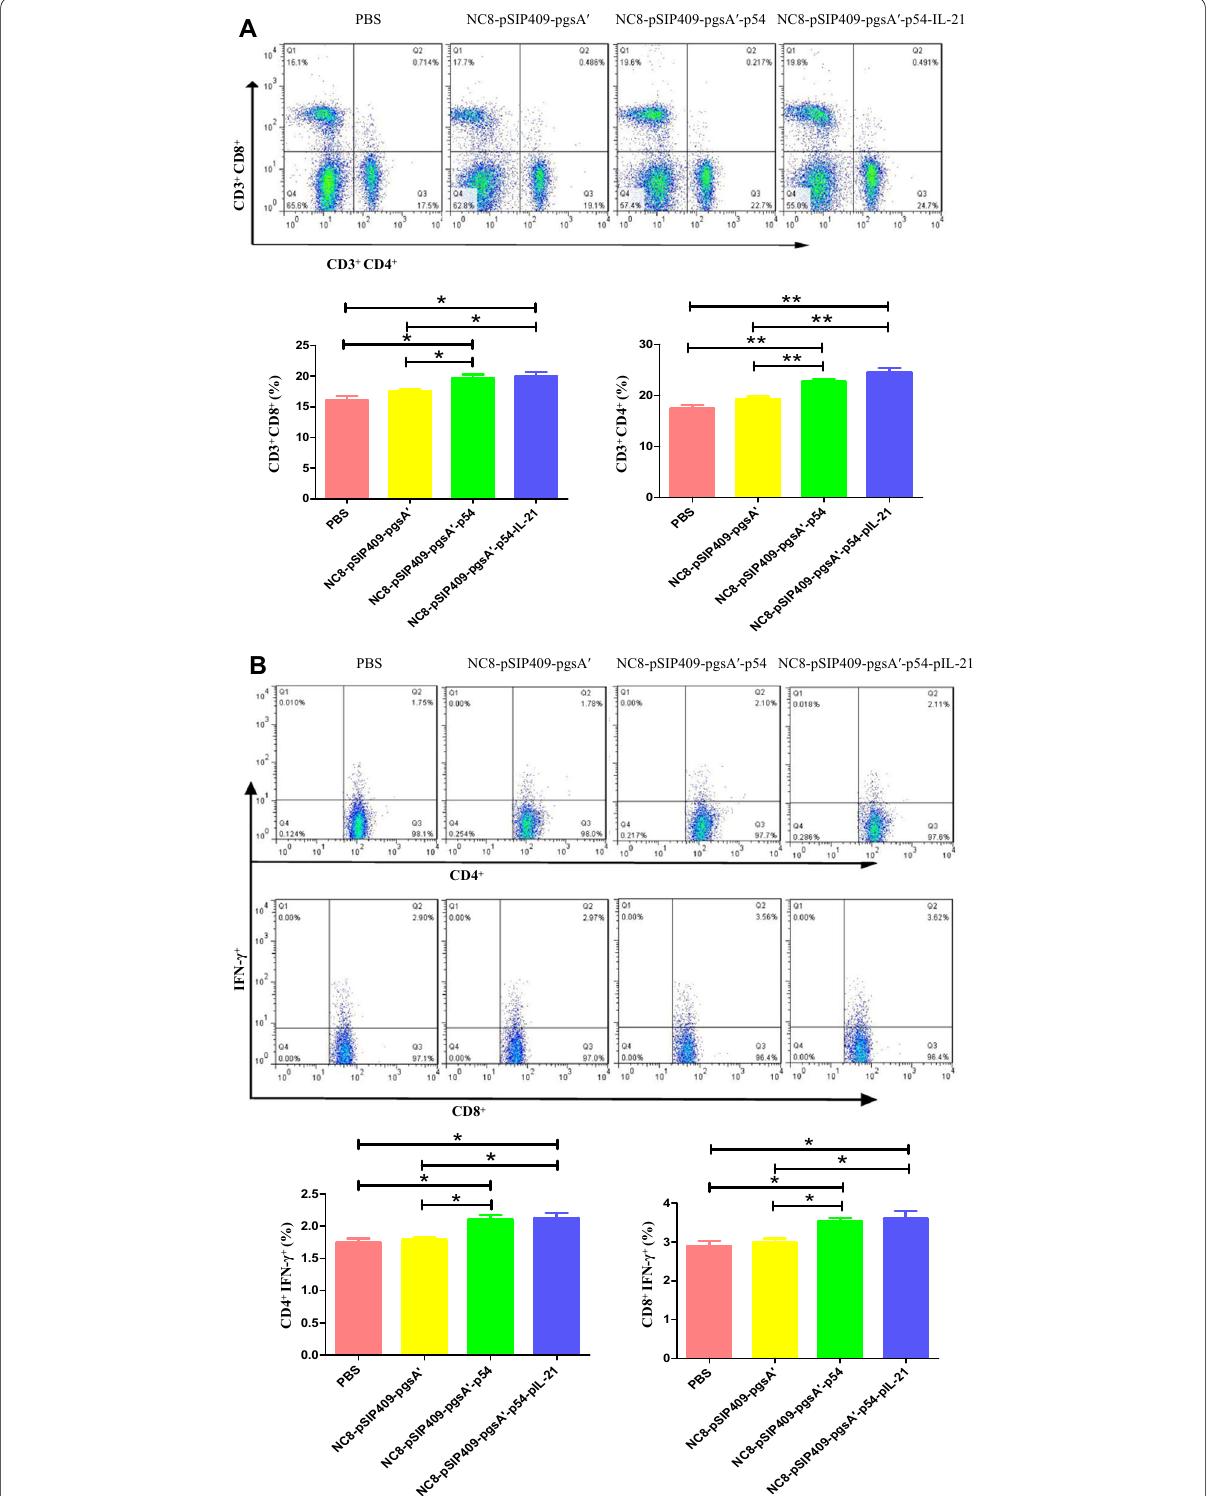
Fig. 4 A Changes in the detection of CD3 + CD4 + and CD3 + CD4 + T cells in the SP; B changes in CD4 + IFN‑γ + and CD8 + IFN‑γ + T cells in the